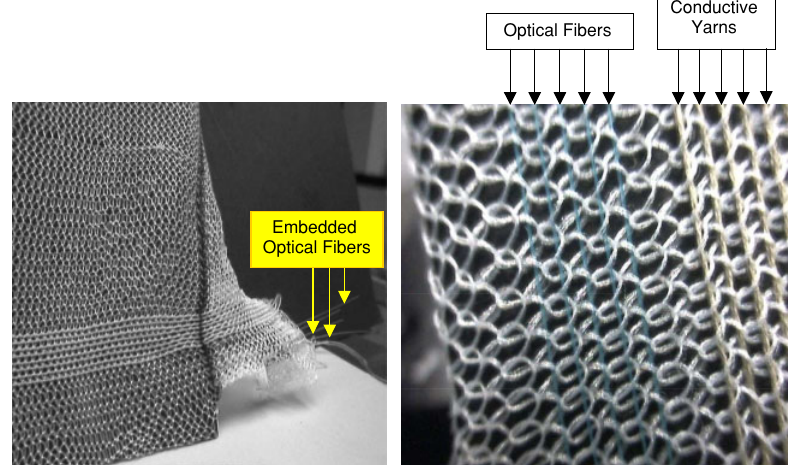
Figure 7 Knitted textile fabric with embedded optical fibers and conductive yarns (left), and the macroscopic picture of the knitted textile structure (right).